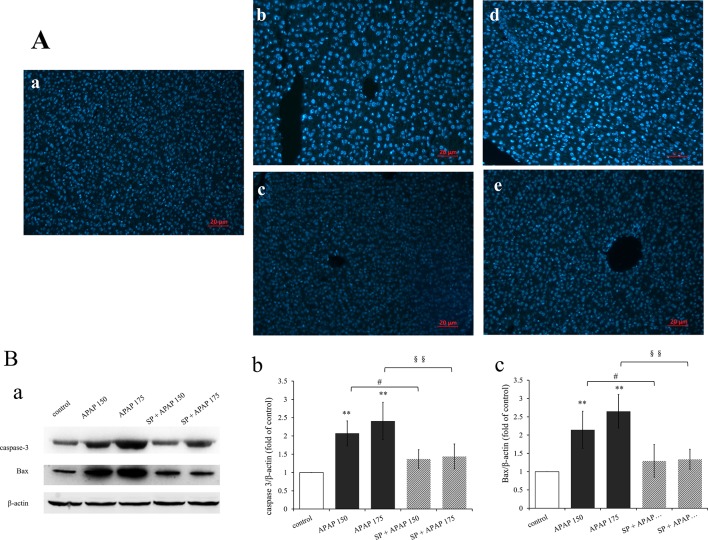
Inhibition of JNK ameliorated APAP induced apoptosis. (A) Liver sections were stained by Hoechst 33258, examined by fluorescence microscope and the images are displayed at 200× magnification. (a) Mice from control group. (b) Mice treated with 150 mg·kg−1 APAP. (c) Mice treated with 150 mg·kg−1 APAP and SP600125. (d) Mice treated with 175 mg·kg−1 APAP. (e) Mice treated with 175 mg·kg−1 APAP and SP600125. (B) Western blot analyses of total tissue lysate for caspase-3, Bax and β-actin (loading control), n = 3. (a) Immunoblot graph of caspase-3 Bax and β-actin. (b, c) Changes of caspase-3 expression (fold of GSTA1/β-actin) and Bax expression (fold of Bax/β-actin) under different dosages of APAP in liver of mice with or without SP600125, n = 3. Values represented as means ± SD. *Represents statistical differences caused by APAP. #Represents statistical differences caused by SP600125 under 150 mg·kg−1 APAP. §Represents statistical differences caused by SP600125 under 175 mg·kg−1 APAP. 0.05 > P > 0.01 (#). P < 0.01 (**, §§).